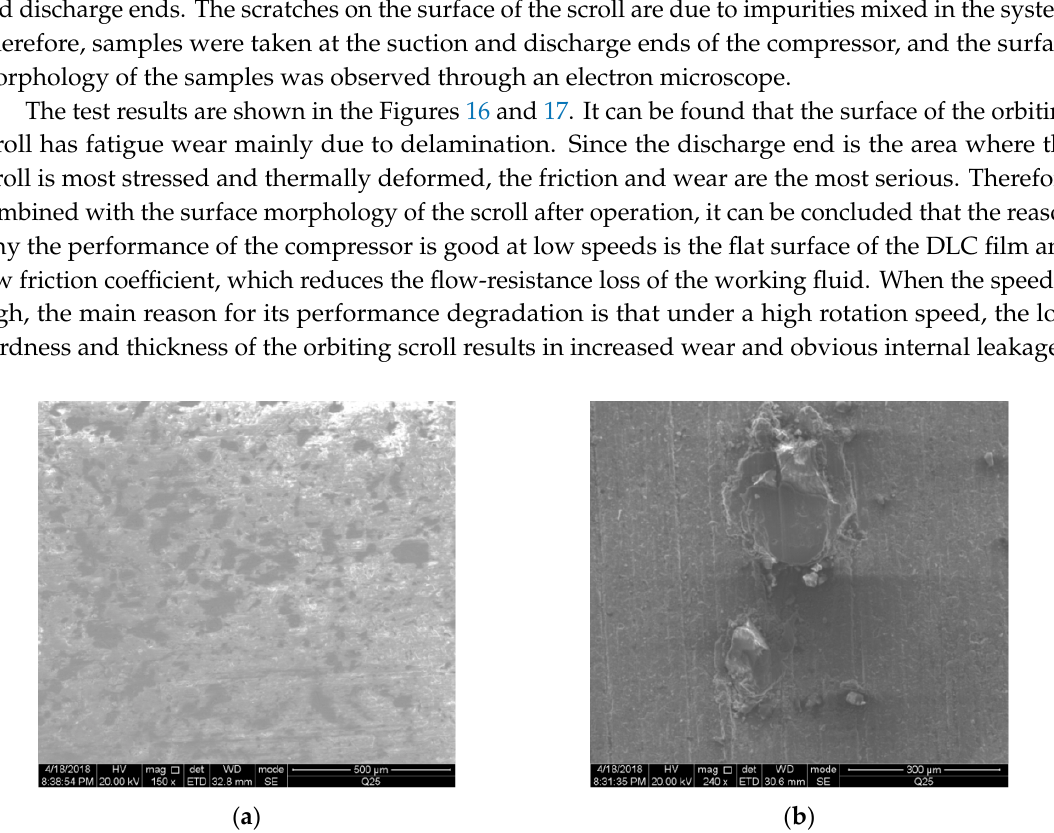
Figure 16. The suction end surface topography of the orbiting scroll after the compressor with DLC film is running: ( a ) 150 times; ( b ) 240 times.